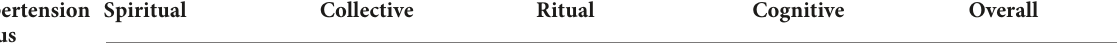
TABLE 4 The influence of coping strategies on control of hypertension.